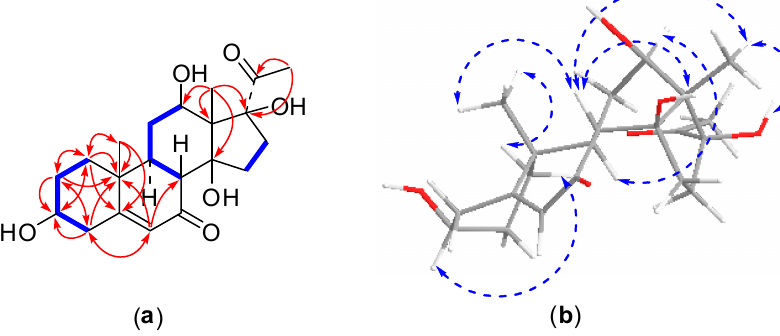
Figure 4. 2D NMR correlations of compound 3 : ( a ) 1 H- 1 H correlations (bold lines) and selected HMBC correlations (arrows); ( b ) selected NOSEY correlations.